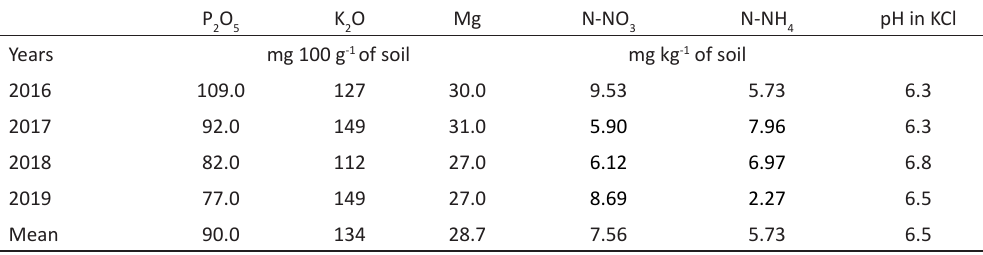
Table 1. Chemical properties of soil before sowing white lupin in